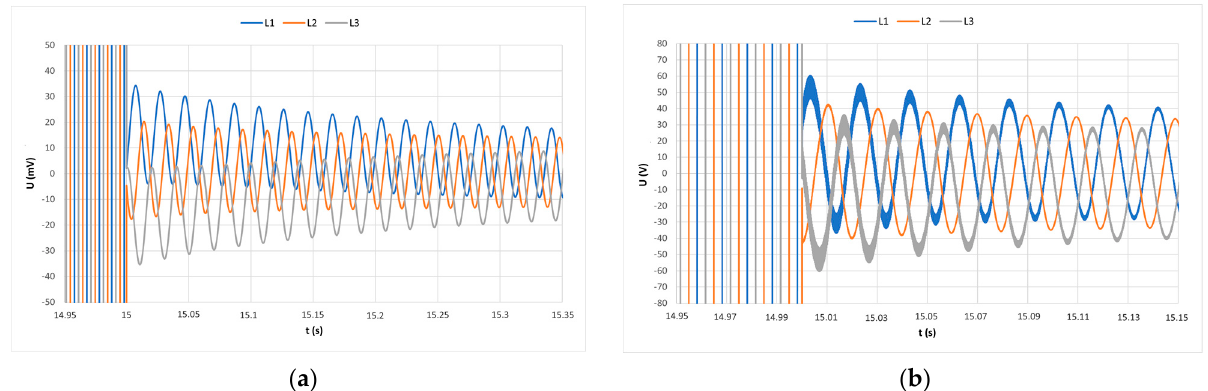
Figure 18. Simulated values of diesel generator model voltages during a 3-Ph ground fault condition at: ( a ) the source; ( b ) the end of transmission line.